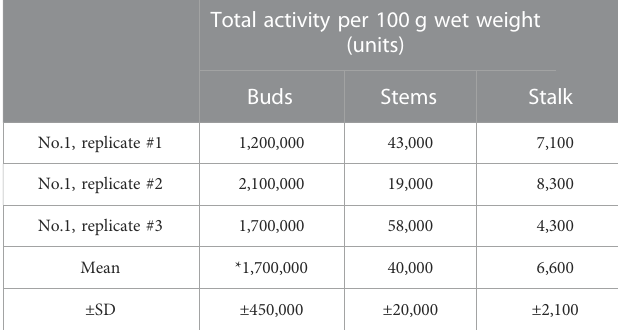
TABLE 1 Total immunostimulatory activity found in the hot-water extracts of broccoli (per 100 g wet weight of each